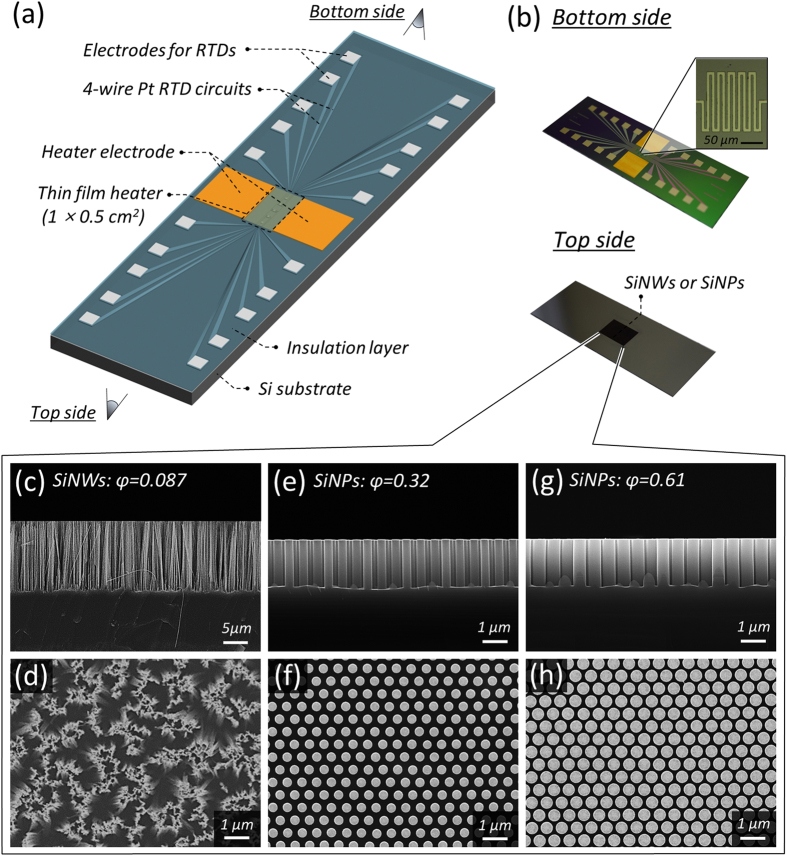
Local temperature-measuring sensor with in situ nanostructures.(a) Schematic diagram of the sensor. (b) Photograph of the completed sensor. (c,d) Silicon nanowires (SiNWs) with solid fraction φ = 0.087: average diameter davg = 100 nm, average pitch pavg = 300 nm, and average height havg = 15 μm. (e,f) Silicon nanopillars (SiNPs) with φ = 0.32: davg = 360 nm, pavg = 610 nm, and havg = 2 μm. (g,h) SiNPs with φ = 0.61: davg = 500 nm, pavg = 610 nm, and havg = 2 μm12.